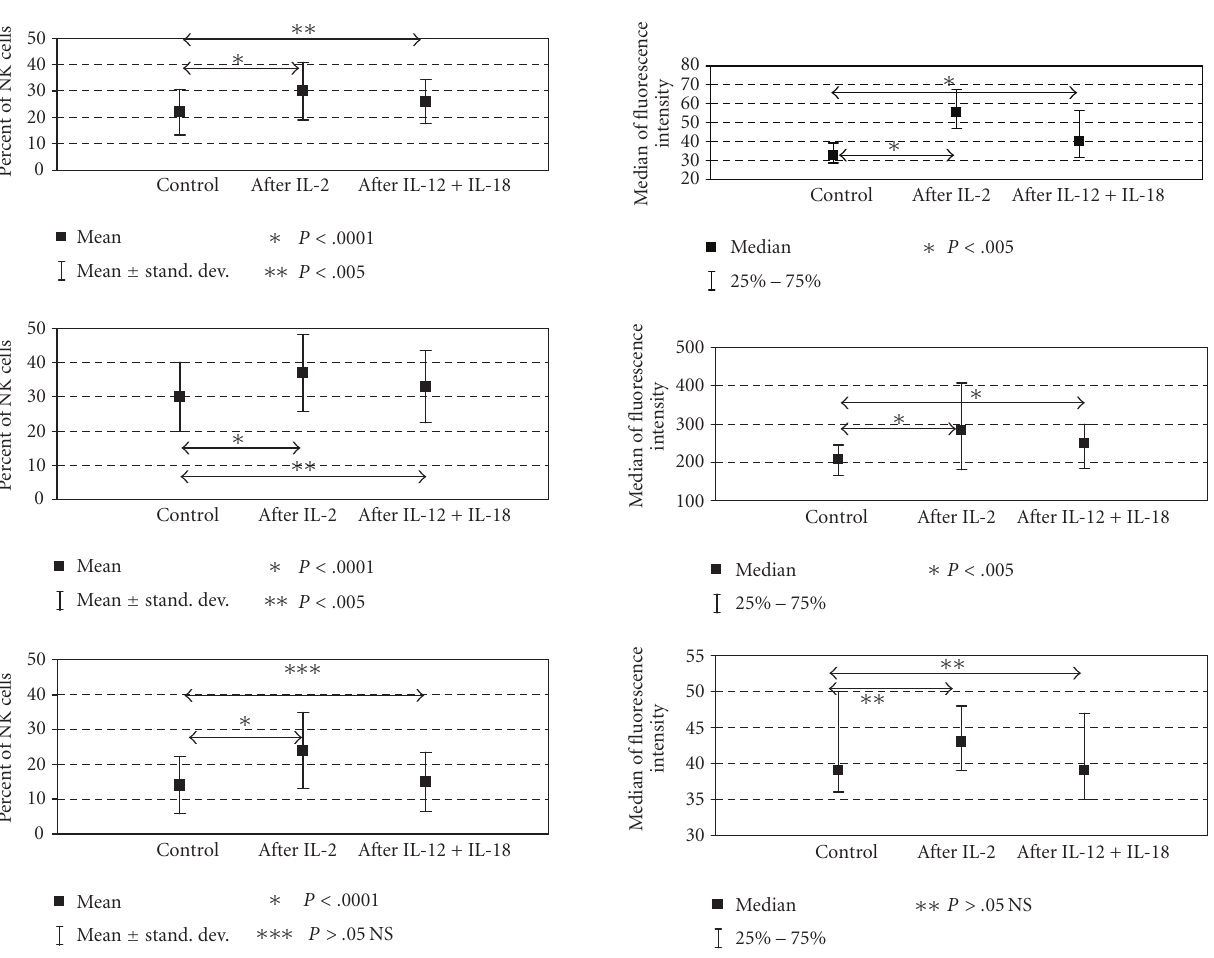
Figure 1: Percentage of NK cells possessing KIR2DL1, KIR2DL2, and KIR3DL2 on the surface. Both IL-2 and IL-12+IL-18 caused sig- nificant increase in the fraction of cells with KIR2DL1 and KIR2DL2 receptors whereas in the fraction of cells with KIR3DL2 receptors only IL-2 caused significant increase. ∗ denotes P < . 0001; ∗∗ de- notes P < . 005; ∗ ∗ ∗ denotes NS (nonsignificant).